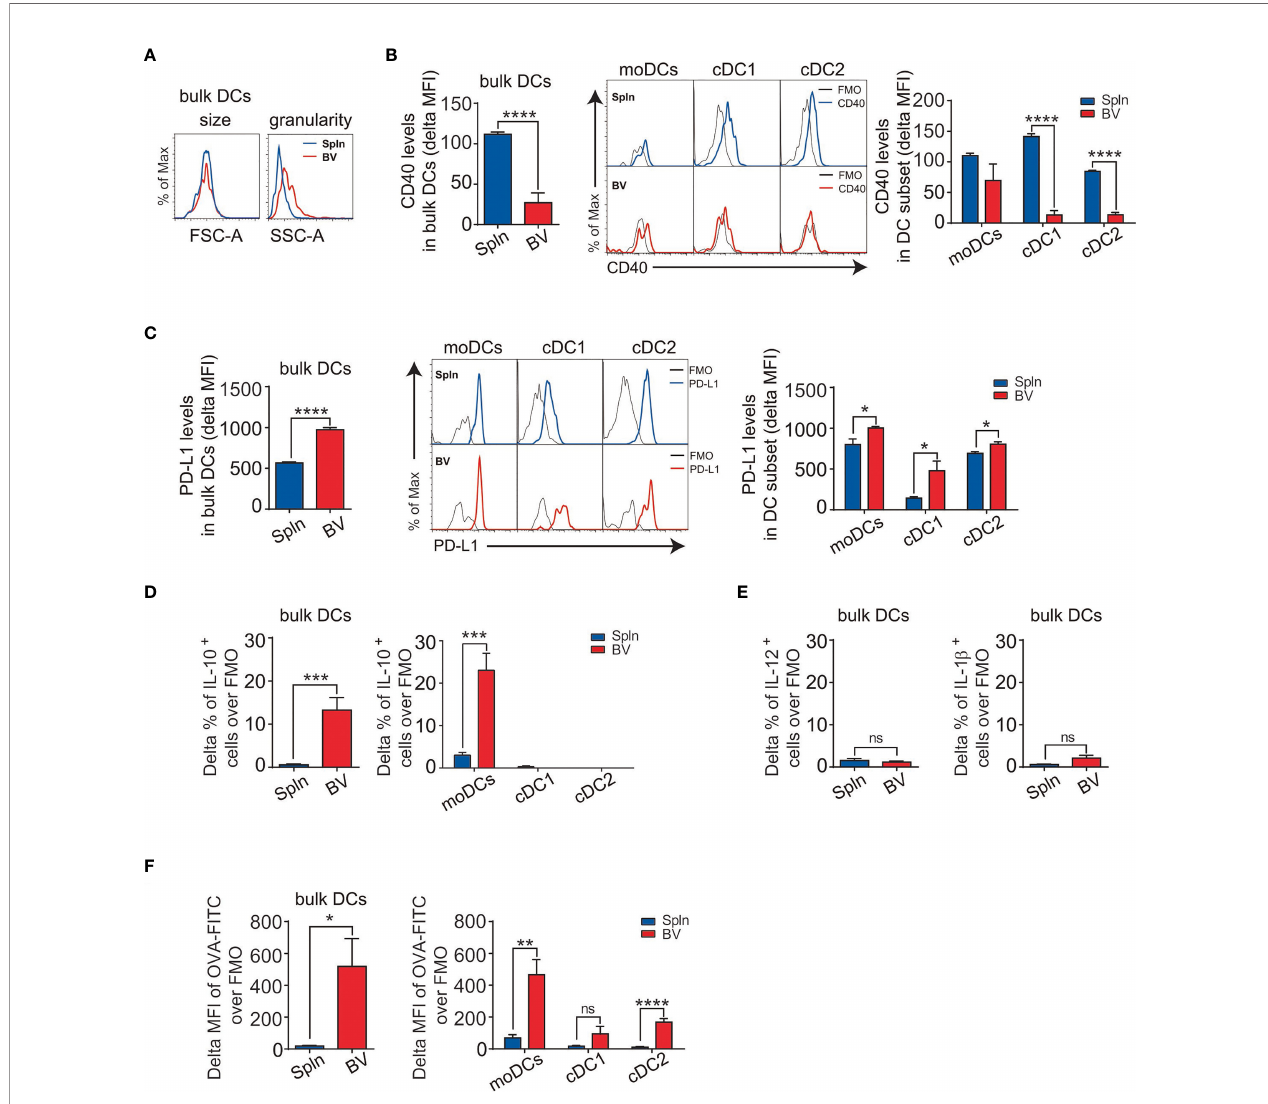
FIGURE 2 | Immature DCs with suppressive activities and superior phagocytotic capacity in vascular tissues at steady state. Tissue single-cell suspensions from BV and Spln of healthy mice were prepared and gated for FACS analysis as in Figure 1 . Plots and graphs show the size and granularity (A) , delta MFI of CD40 (B) , delta MFI of PD-L1 (C) expression, and delta percentage of IL-10 (D) in bulk DCs and their subsets, as well as IL-12/IL-1 b (E) in bulk DCs. Alternatively, mice were injected with OVA-FITC for 6 h before the delta MFI of OVA-FITC in bulk DCs and their subsets (F) were analyzed. Shown here are representative plots of experiments with at least three biological replicates. The data are shown as mean ± SEM ( n = 3 – 9 mice) and analyzed using Student ’ s t -test. * p < 0.05; ** p < 0.01; *** p < 0.001; **** p < 0.0001. ns, no signi fi cant